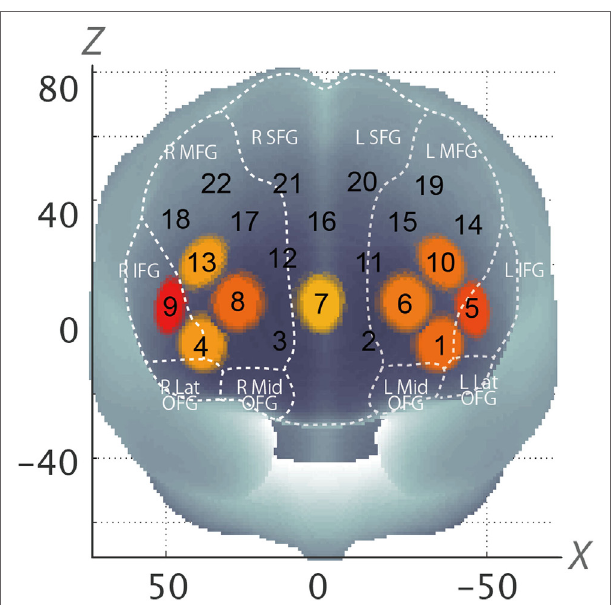
FigUre 2 | Statistically estimated fNIRS channel locations for the subjects are exhibited in MNI space. Channels showing significant oxy-Hb change are circled and colored yellow to red depending on p -values (Corresponding to Table 3 ). SFG, superior frontal gyrus; MFG, middle frontal gyrus; IFG, inferior frontal gyrus; OFG, orbitofrontal gyrus; oxy-Hb, oxygen hemoglobin; fNIRS, functional near-infrared spectroscopy; MNI, Montreal Neurological Institute.